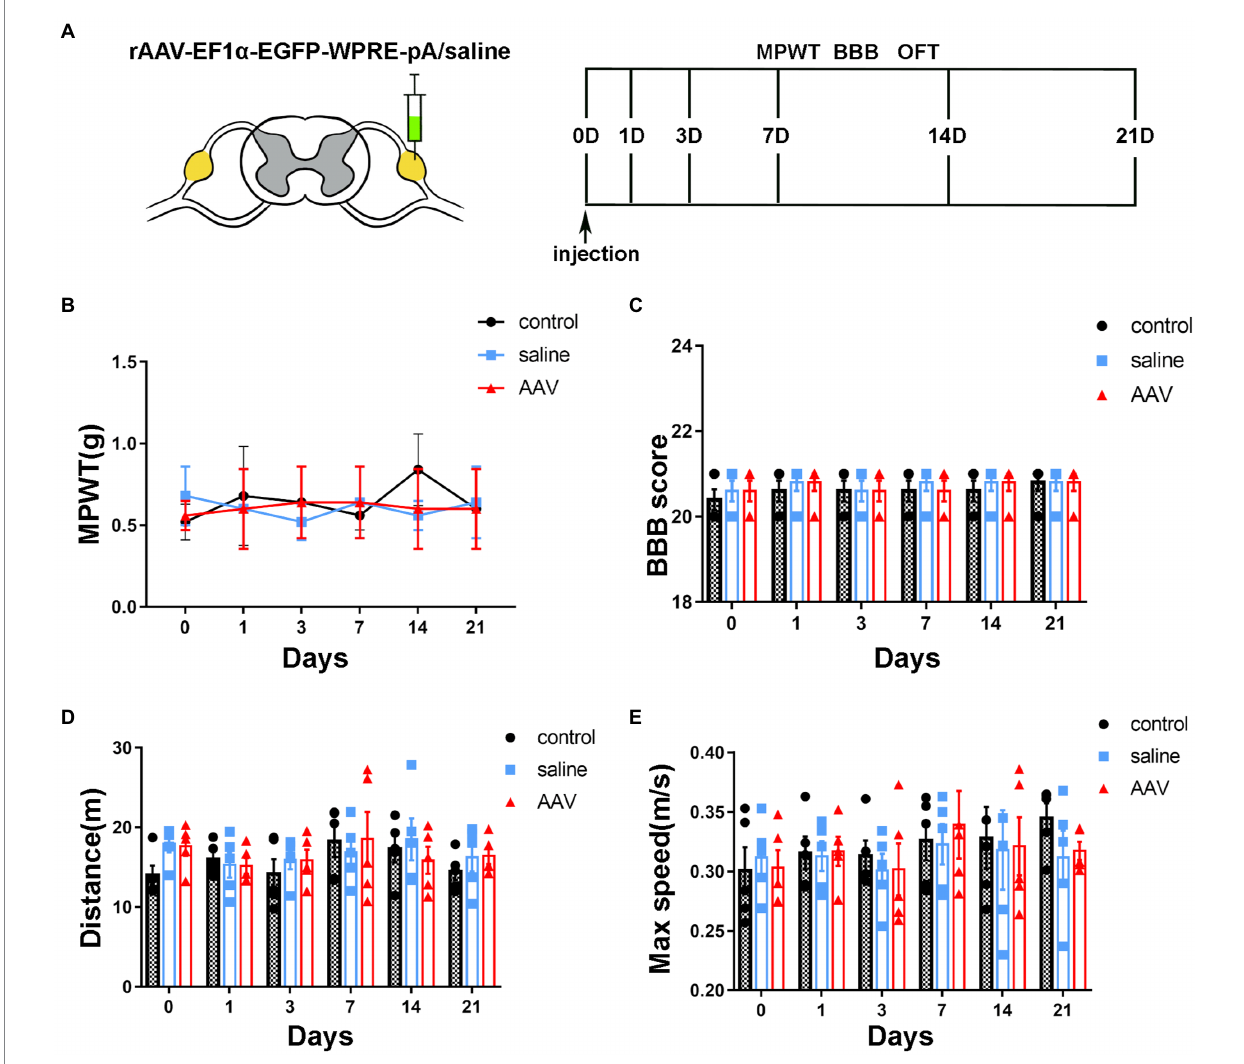
FIGURE 5 Changes in sensory and motor function after surgery and injection. (A) The schedule of administrating AAV or saline, BBB test, MPWT and OFT. (B) Compared to the control group, no effect is observed on the sensory function after saline or AAV administration ( p > 0.05, n = 5 mice per group). (C) The scores of the control, saline and AAV groups are similar at the corresponding time points ( p > 0.05, n = 5 mice per group). The manipulation had no effect on motor function. (D,E) In the OFT, there are no significant differences in the distance and maximum velocity among the three groups ( p > 0.05, n = 5 mice per